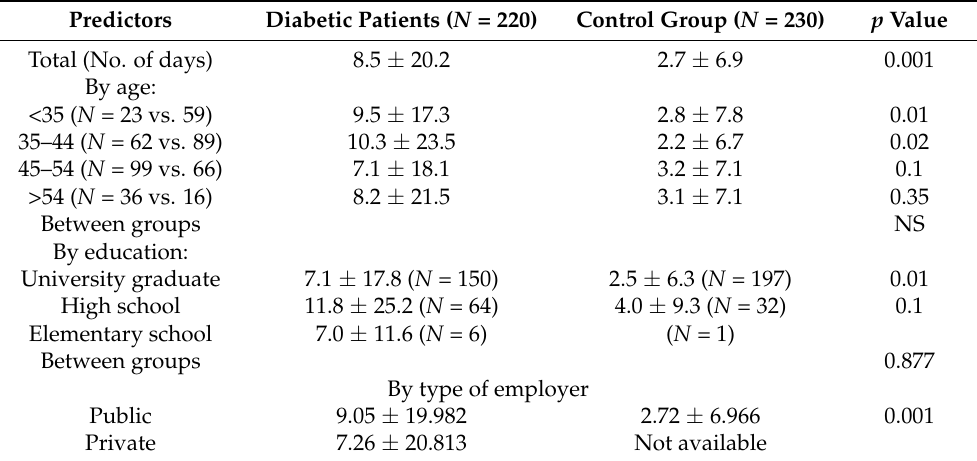
Table 2. Days of sickness absence along one year of follow-up by age, education, and employer’s type.